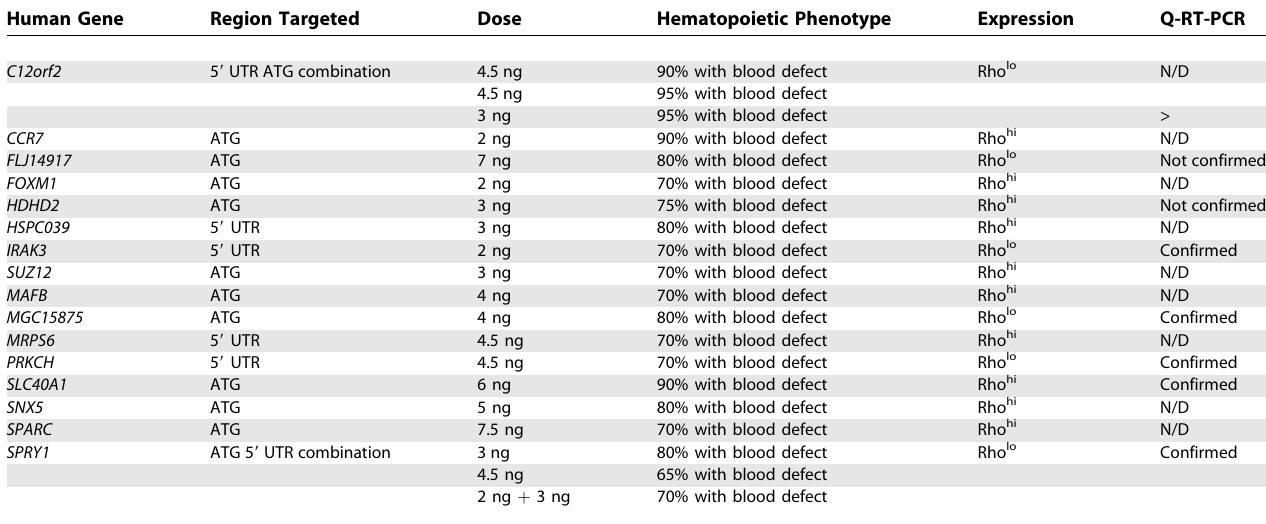
Table 1. Genes Differentially Expressed between Human Rho lo and Rho hi Cell Populations That Have a Functional Role in Zebrafish Hematopoietic Development Human Gene Region